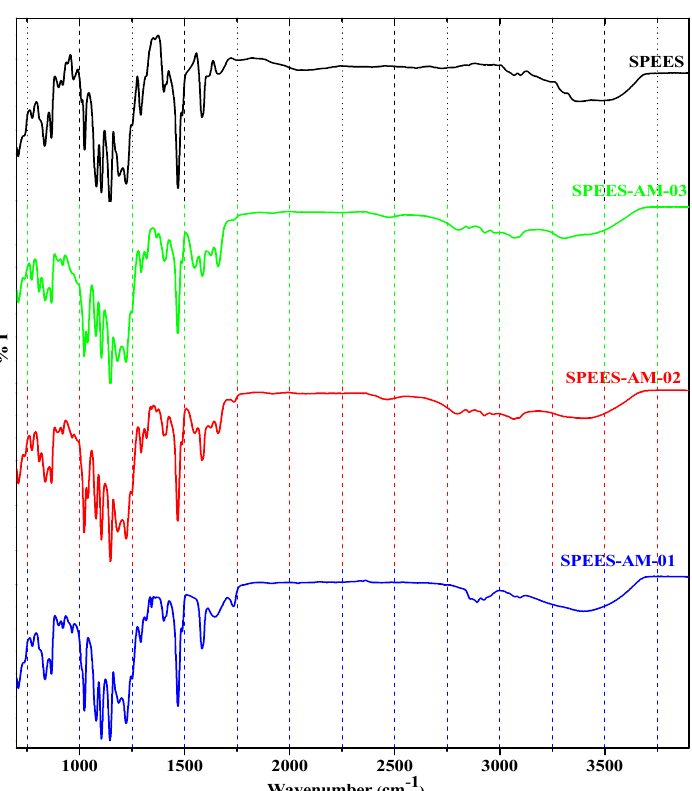
Figure 2. FT-IR for SPEES, SPEES-AM-01, SPEES-AM-02, and SPEES-AM-03.